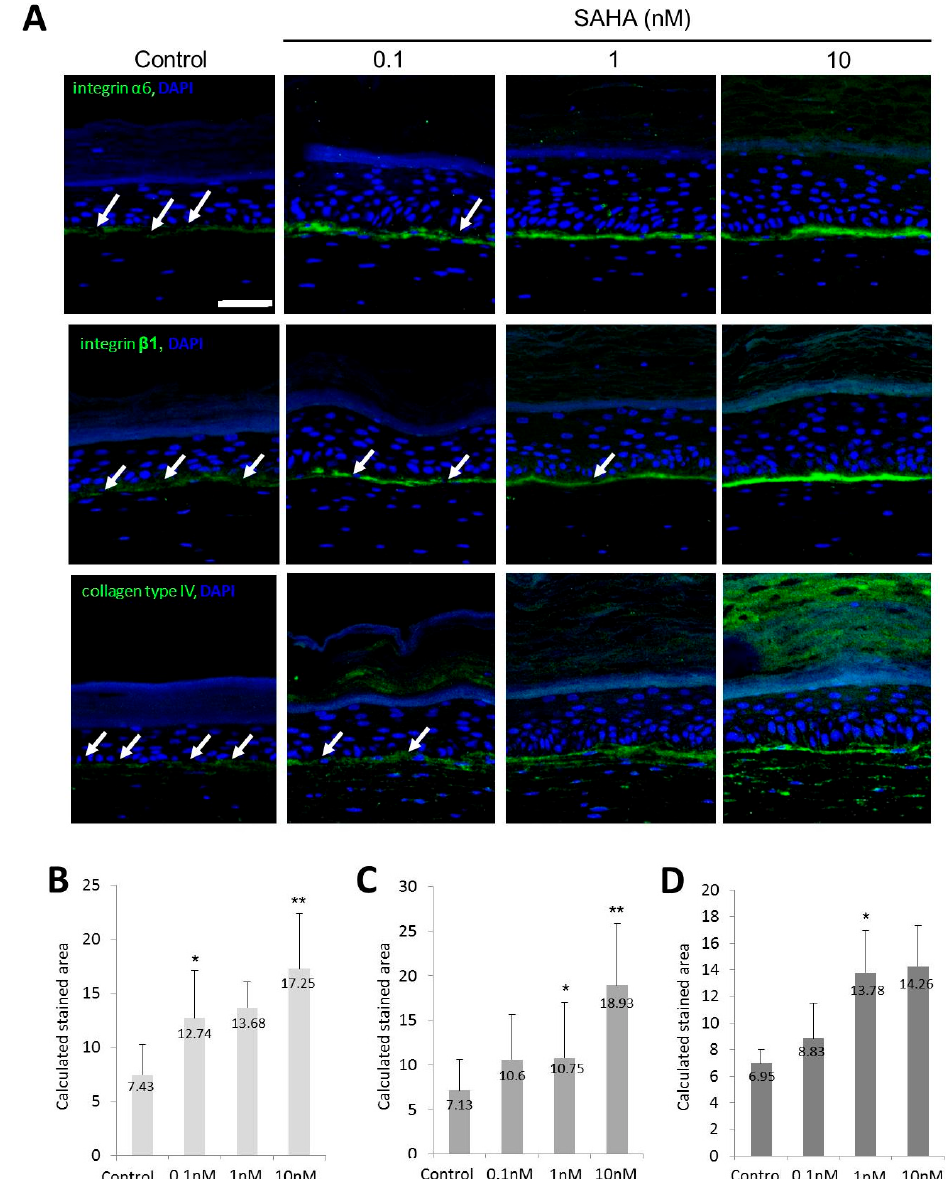
Figure 6. Expression of markers associated with basement membrane in SE. ( A ) Staining of integrin α 6, integrin β 1, and type IV collagen along the basement membrane in SAHA treated samples. Discontinuity was shown by white arrow (green; integrin α 6, integrin β 1, and type IV collagen respectively, × 200, scale bar is 50 µ m); ( B ) Calculated stained area for integrin α 6; ( C ) Calculated stained area for integrin β 1 after SAHA treatment; ( D ) Calculated stained area for type IV collagen after SAHA treatment. Six circular areas were selected and the average area stained above a certain intensity was determined. Statistical significance was calculated with the Mann-Whitney- U test, * p < 0.05 compared with the control, ** p < 0.01 compared with the control. This experiment was repeated twice and representative areas are shown.